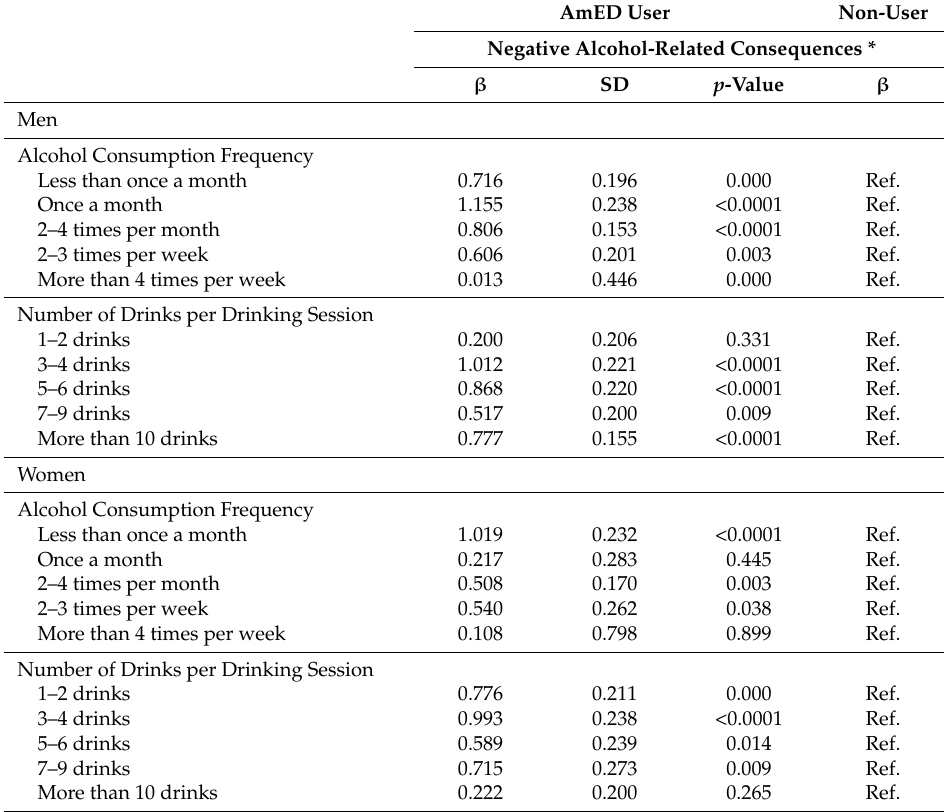
Combined effects of drinking behavior and AmED use on negative alcohol- related